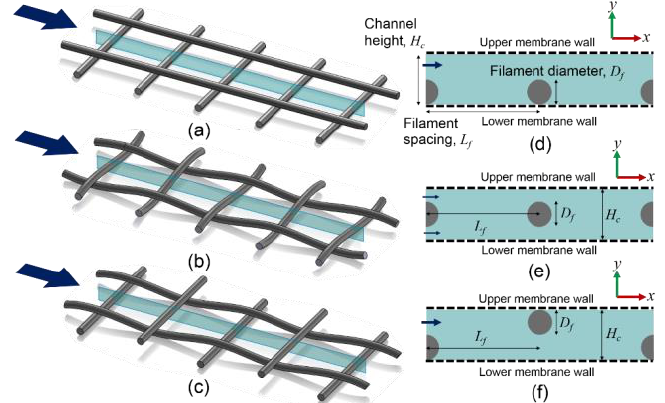
Figure 1. Three-dimensional spacer geometries ( a – c ) and their cross-sections along the main flow path ( d – f ). ( a ) Nonwoven spacer, ( b ) fully woven spacer, ( c ) partially woven spacer. 2D cross-sections: ( d ) cavity, ( e ) submerged, and ( f ) zigzag